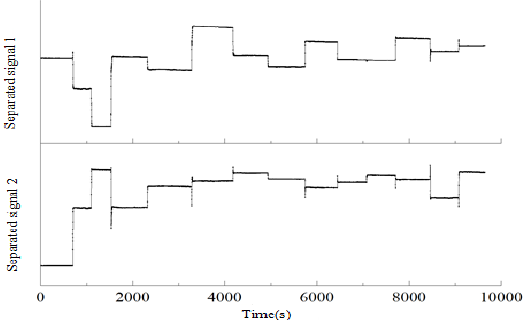
Fig. 5. Variation Trend of Separated